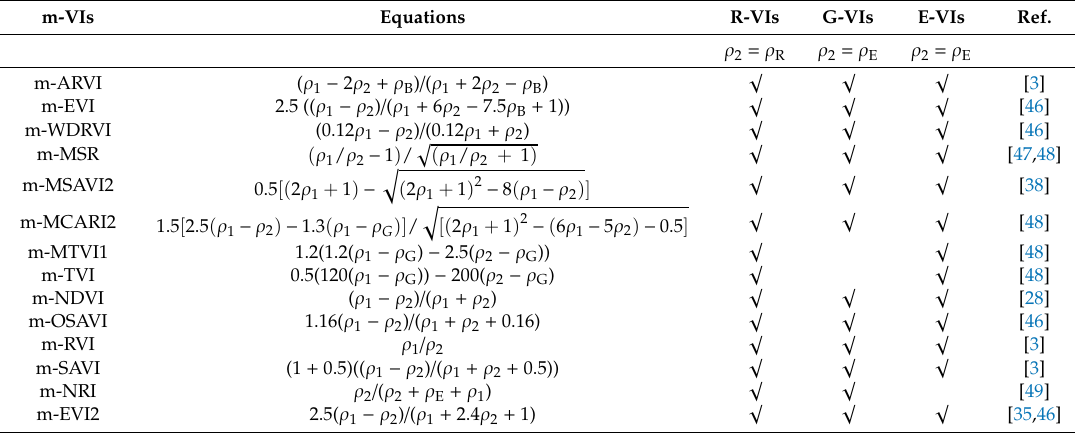
Table 7. Bands and VIs used in this